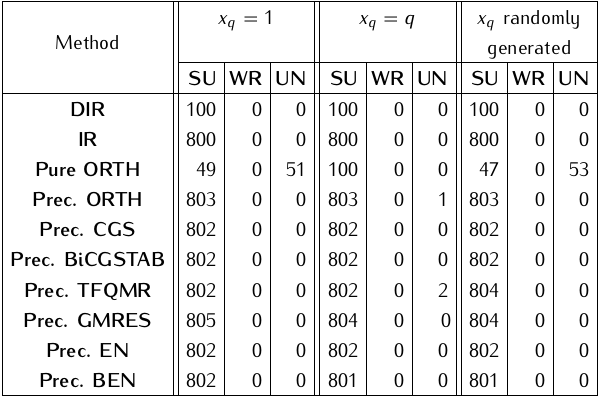
Table 14. The same as Table 12, but the relative residual stopping criterion defined by